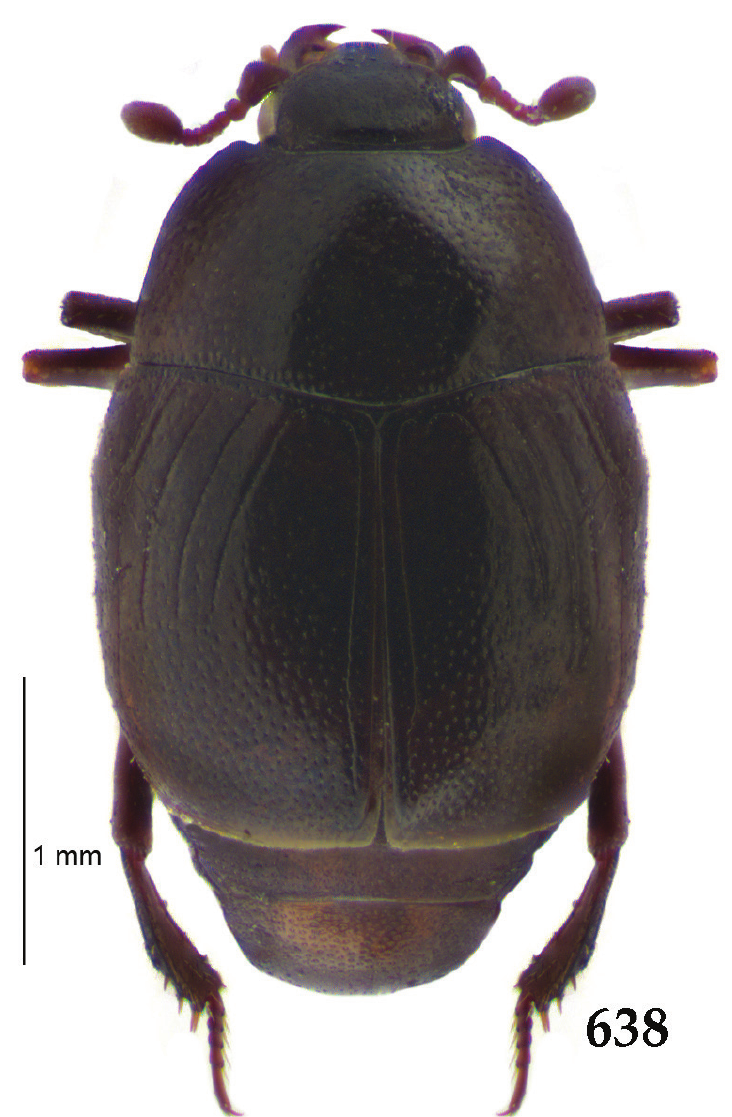
Figure 638. Tomogenius incisus (Erichson, 1842) habitus, dorsal view.